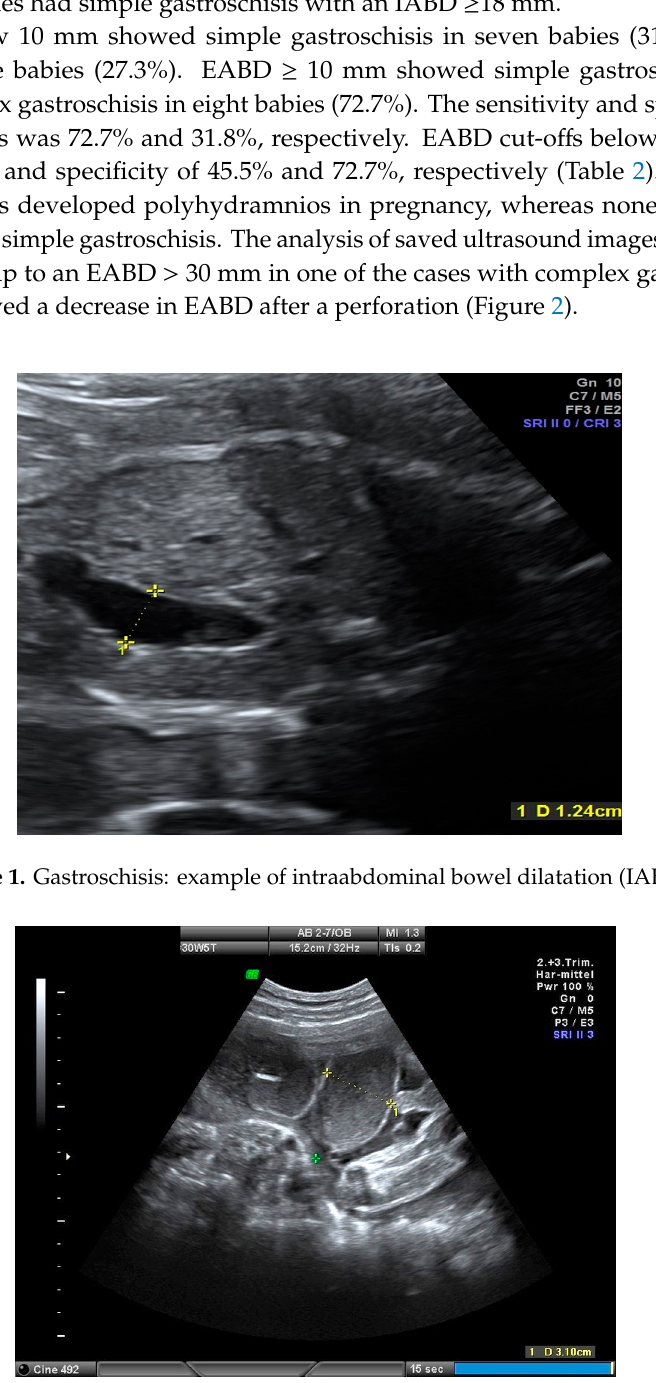
Figure 2. Gastroschisis: example of extra-abdominal bowel dilatation (EABD).